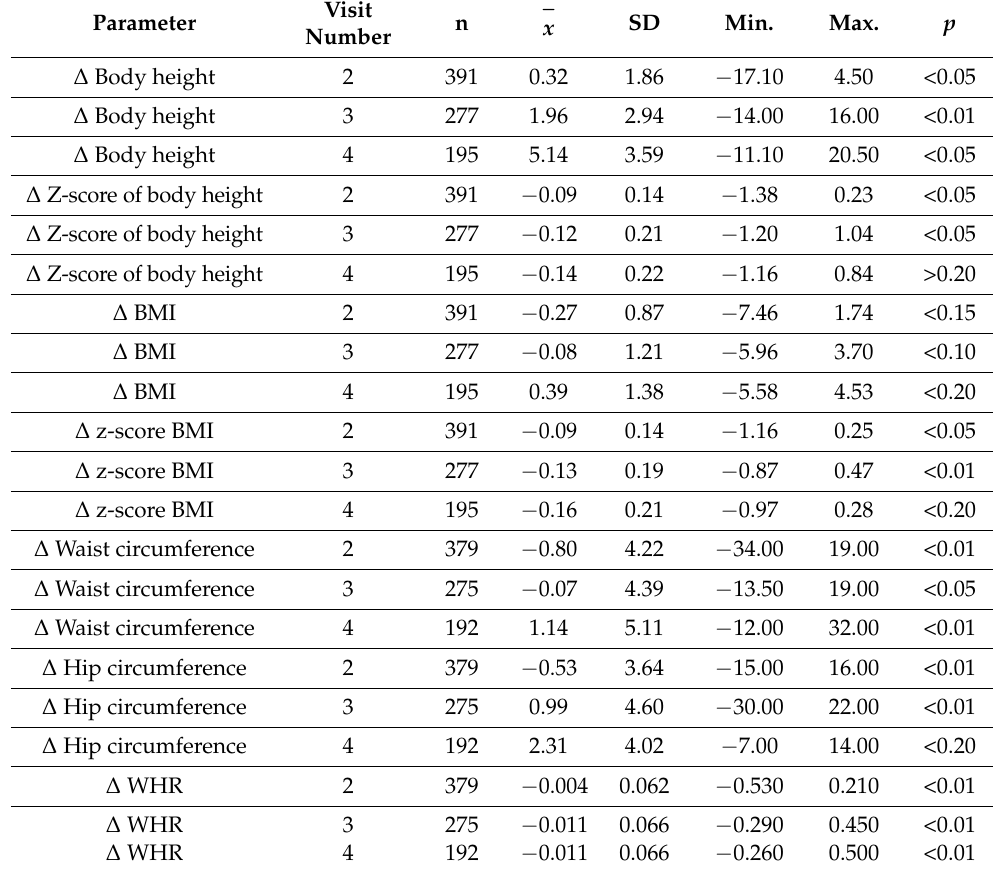
Table 2. Auxological variables of the study group.